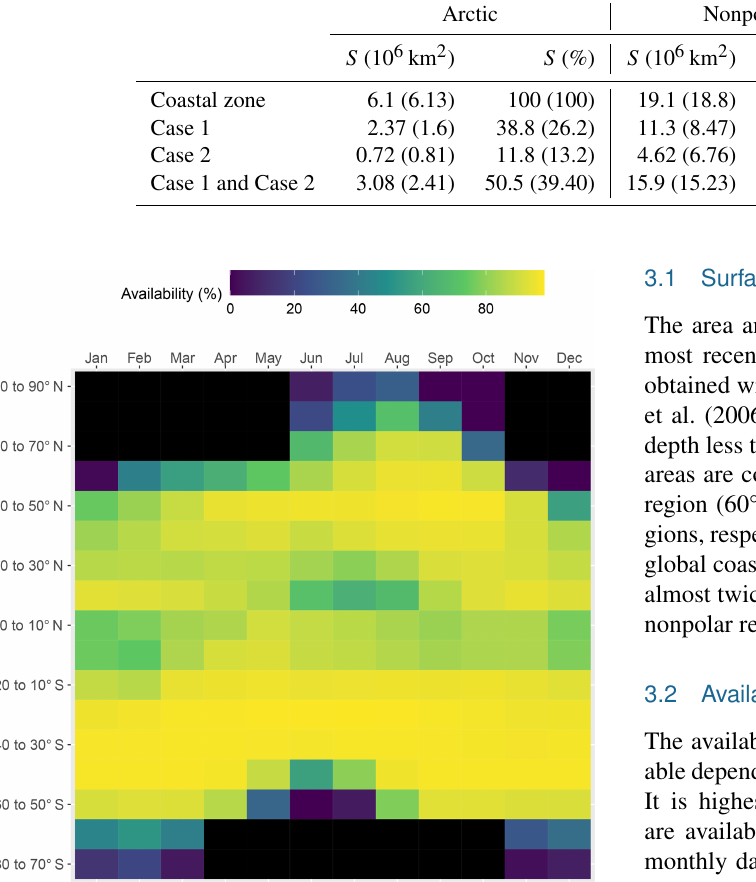
Figure 1. Availability of remote sensing data over the 21 year time series. Availability is expressed as the monthly mean of the percent area of each latitudinal band covered by the